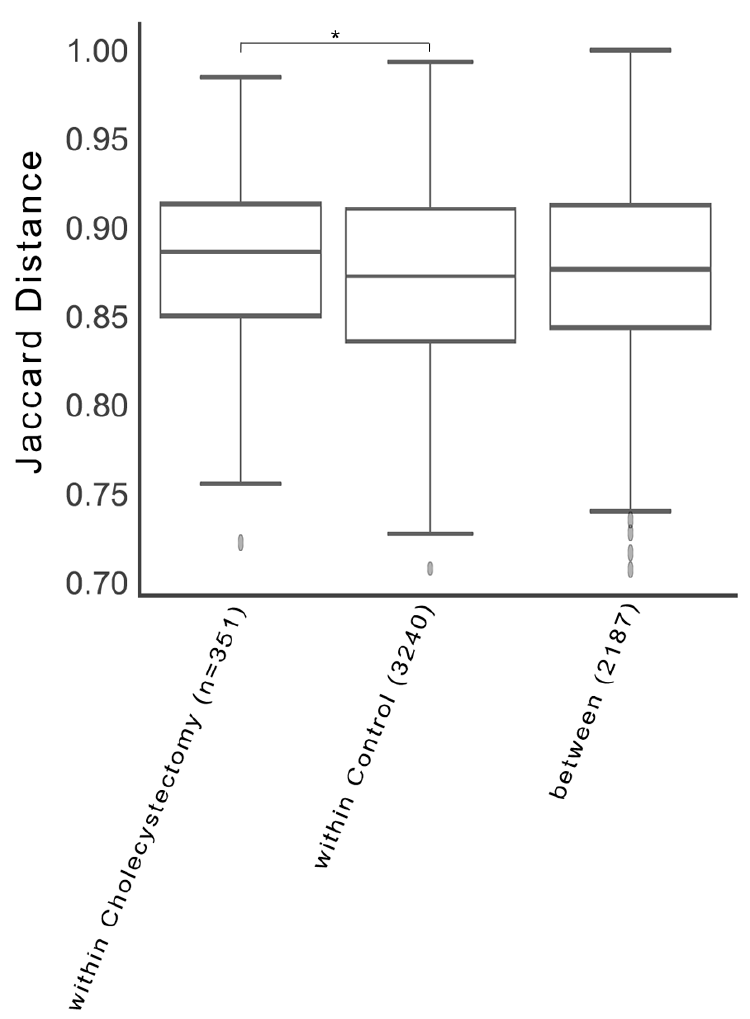
Figure 2. Beta-diversity indices of the cholecystectomy and control groups. From left, the Jaccard distances within the cholecystectomy group, within the control group, and between the cholecystectomy and control groups. * q = 0.027 (pseudo- F = 1.213, permutations = 999, PERMANOVA).